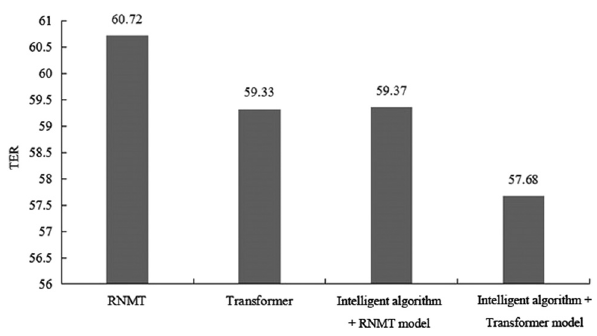
Figure 2: The comparison of the average TER between di ff erent algorithms.